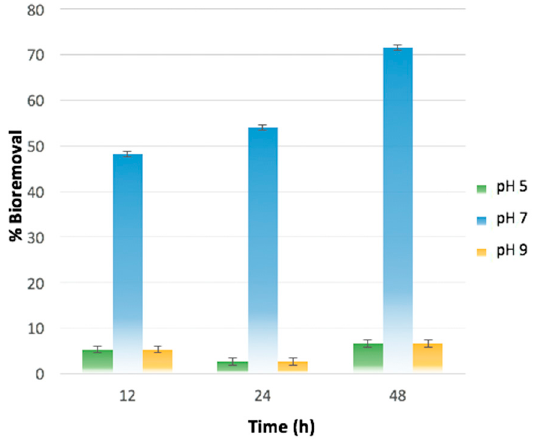
Figure 2. Effect of the pH on the biodegradation of methylene blue (MB) dye at the initial MB concentration (50 ppm), and at the temperature of 35 °C.